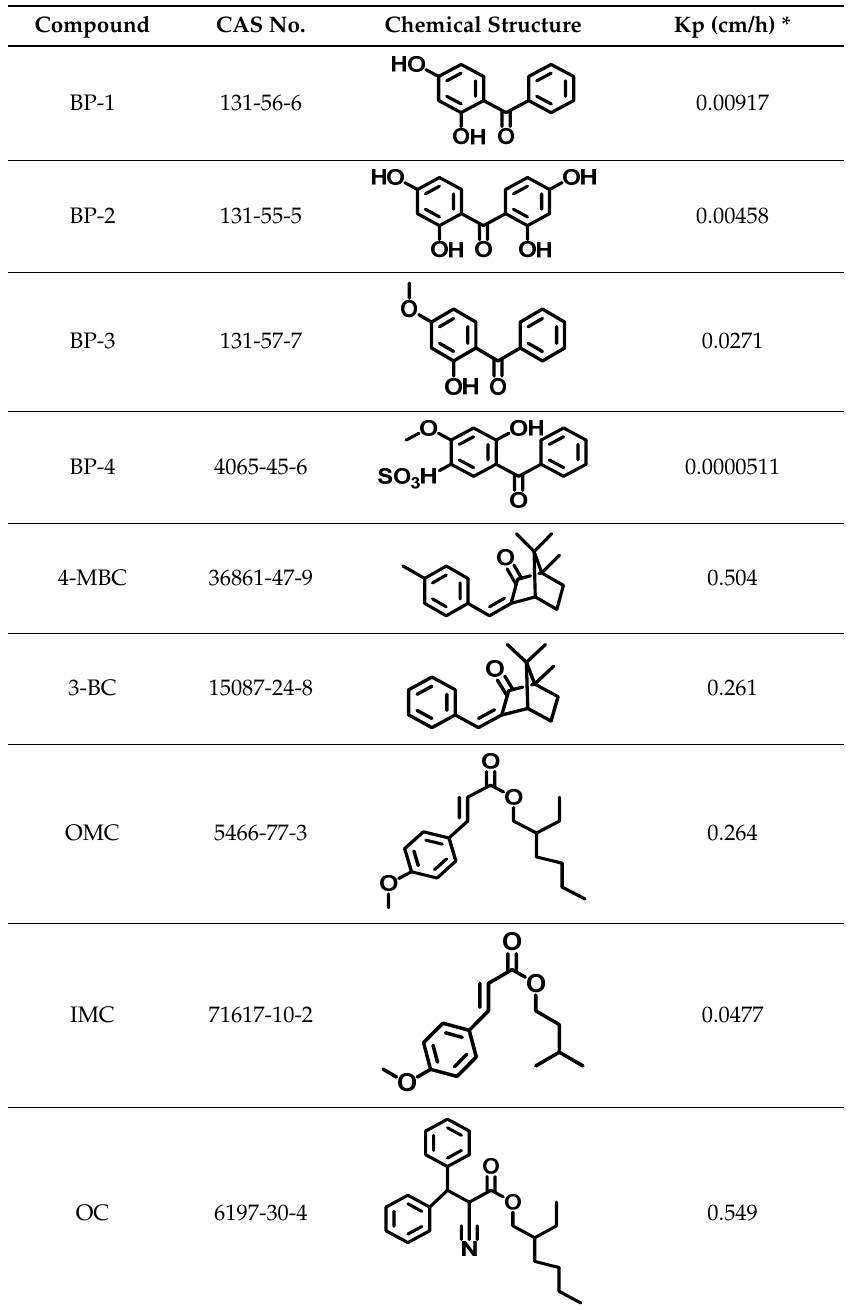
Table 1. The commonly used ultraviolet (UV) filters.